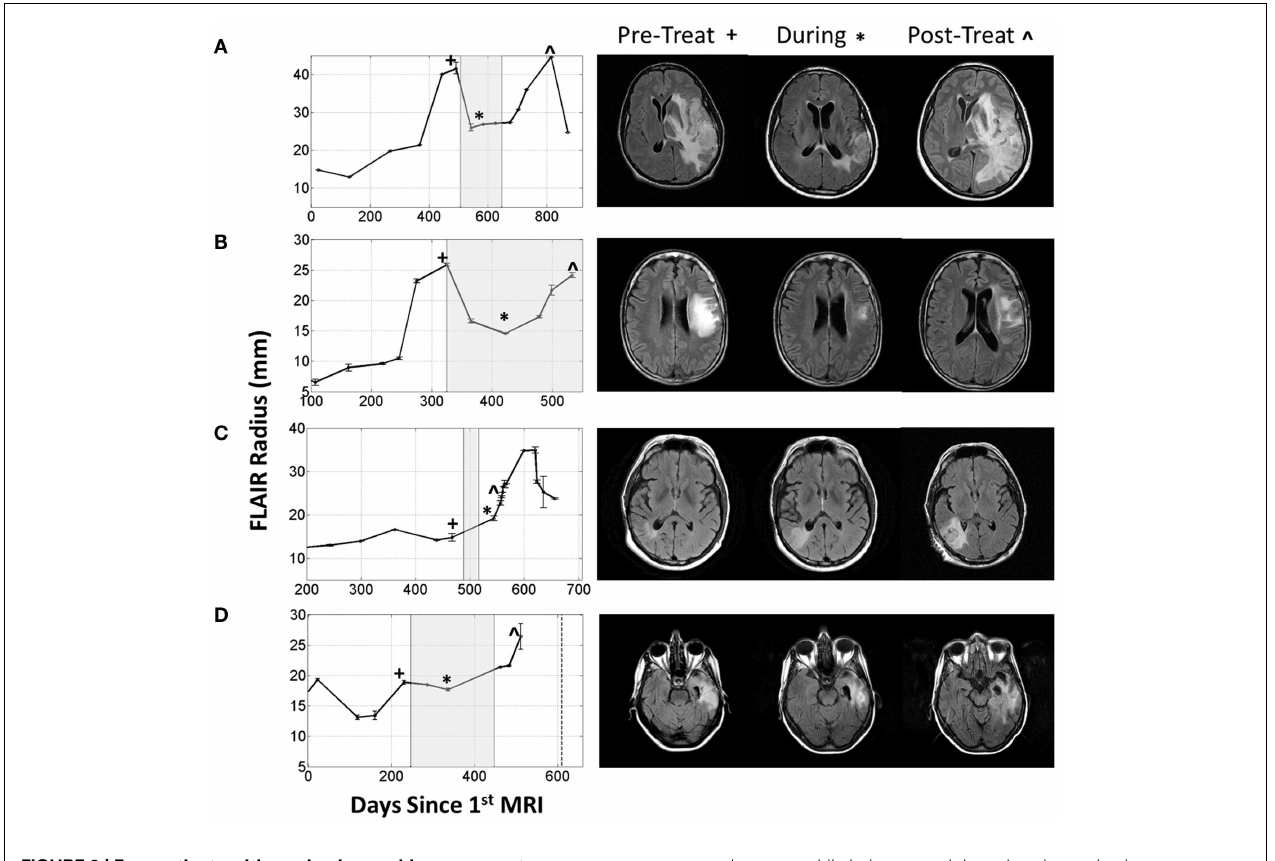
FIGURE 2 | Four patients with varying imageable responses to anti-angiogenic treatment. Treatment period indicated with gray box on radius plots. (A) Patient 1: A 48-year-old male with Grade III glioma is seen to have significant reduction of enhancing lesion during treatment but recurs almost immediately after treatment is stopped, (B) Patient 2: a 55-year-old male with GBM initially responds to